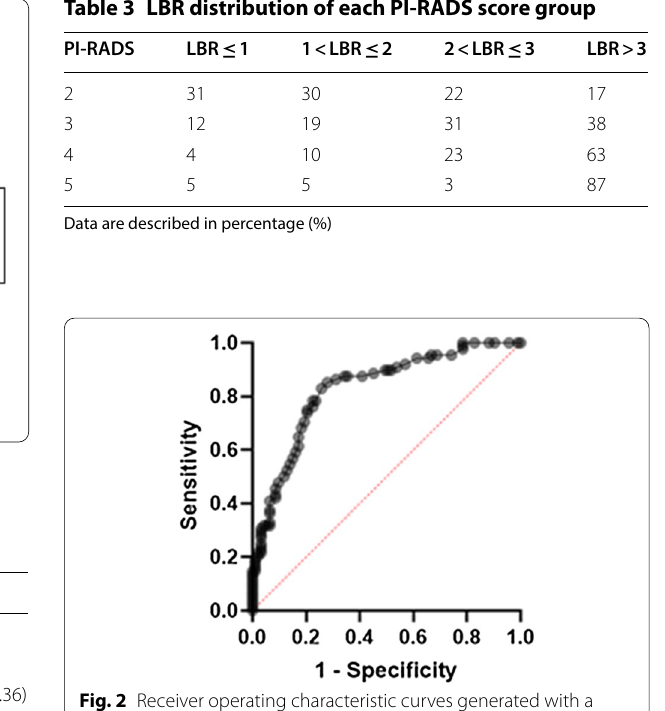
Table 3 LBR distribution of each PI-RADS score group